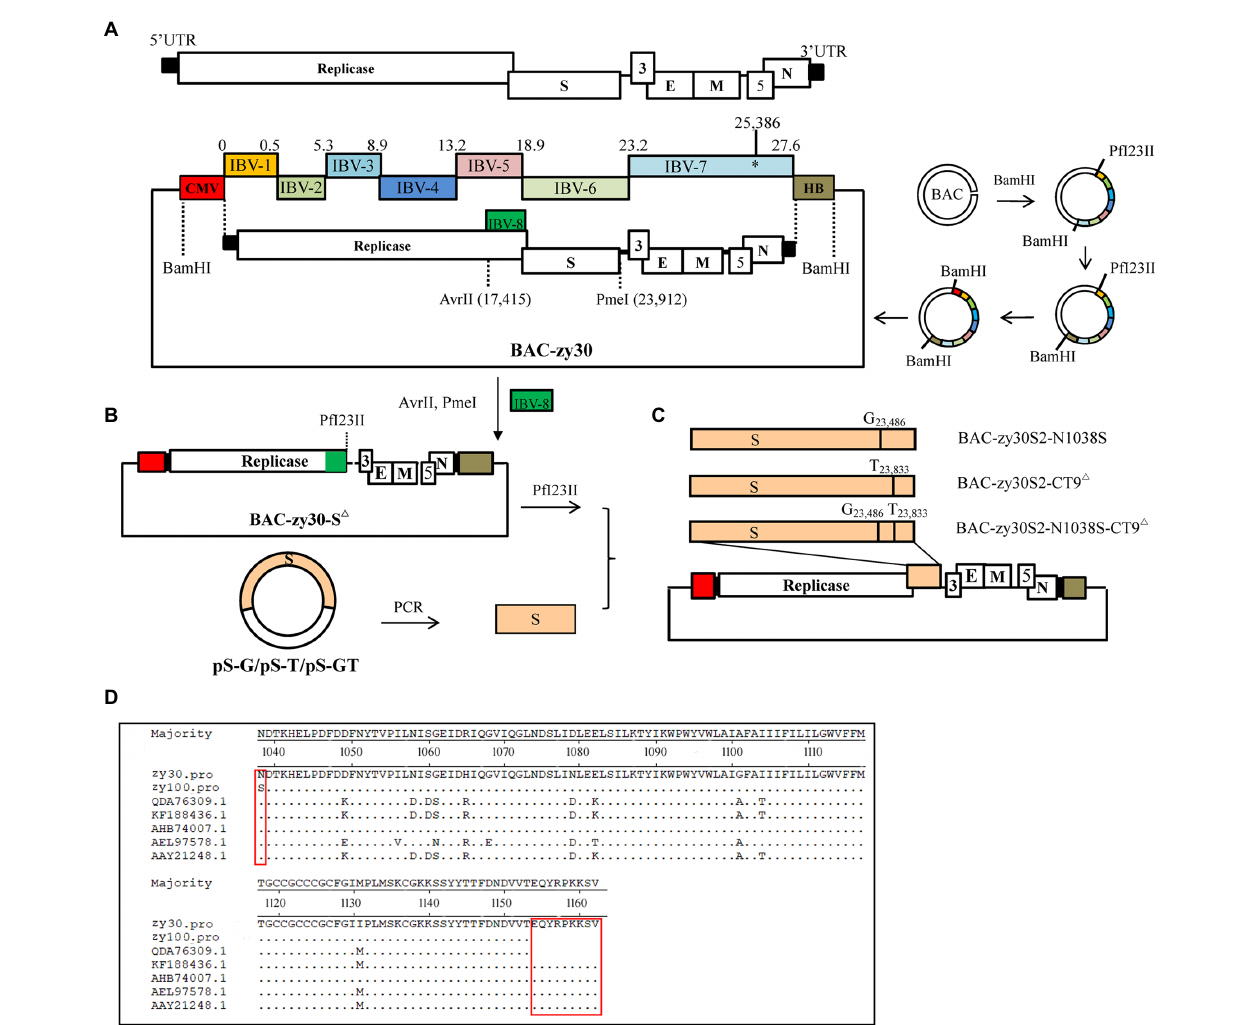
FIGURE 1 | Schematic diagram of the assembly of the full-length IBV cDNA in a BAC plasmid. (A) Genome schematics showed the length of 27 kb for the IBV zy30 strain. The regions coding for the replicase polyproteins, the structural proteins spike (S), envelop (E), matrix (M), and nucleocapsid (N) proteins, and the accessory proteins (3a, 3b, 5a, and 5b) were also indicated. UTR: untranslated regions. The IBV genomic cDNA sequence of IBV QX-like zy30 strain was assembled in plasmid pBeloBAC11 by sequentially cloning PCR fragments IBV-1 to IBV-7 using the BamHI restriction enzyme. Then, the HB fragment containing hepatitis delta virus (HDV) ribozyme and the bovine growth hormone (BGH) termination sequence was cloned behind zy30 3 ʹ terminal using the BamHI restriction enzyme, and the CMV promoter was cloned to the front of the zy30 5 ʹ terminus using the PfI23II restriction enzyme. (B) The intermediate plasmid BAC-zy30-S △ with complete S gene sequence deletion and plasmids PS-G, PS-T, and PS-GT with different substitutions in the S gene were constructed. (C) The three mutated S gene fragments were introduced into the BAC-zy30-S △ plasmid, to assemble three full-length genomic cDNA sequences containing the different mutant S genes. (D) Alignment of the S2 subunit between IBV strains Beaudette (GenBank accession number AAY21248), M41 (QDA76309.1), 4/91 (AEL97578.1), IBYZ (AHB74007.1), H120 (KF188436), zy30, and zy100 were shown. The amino acid differences were labeled with a red